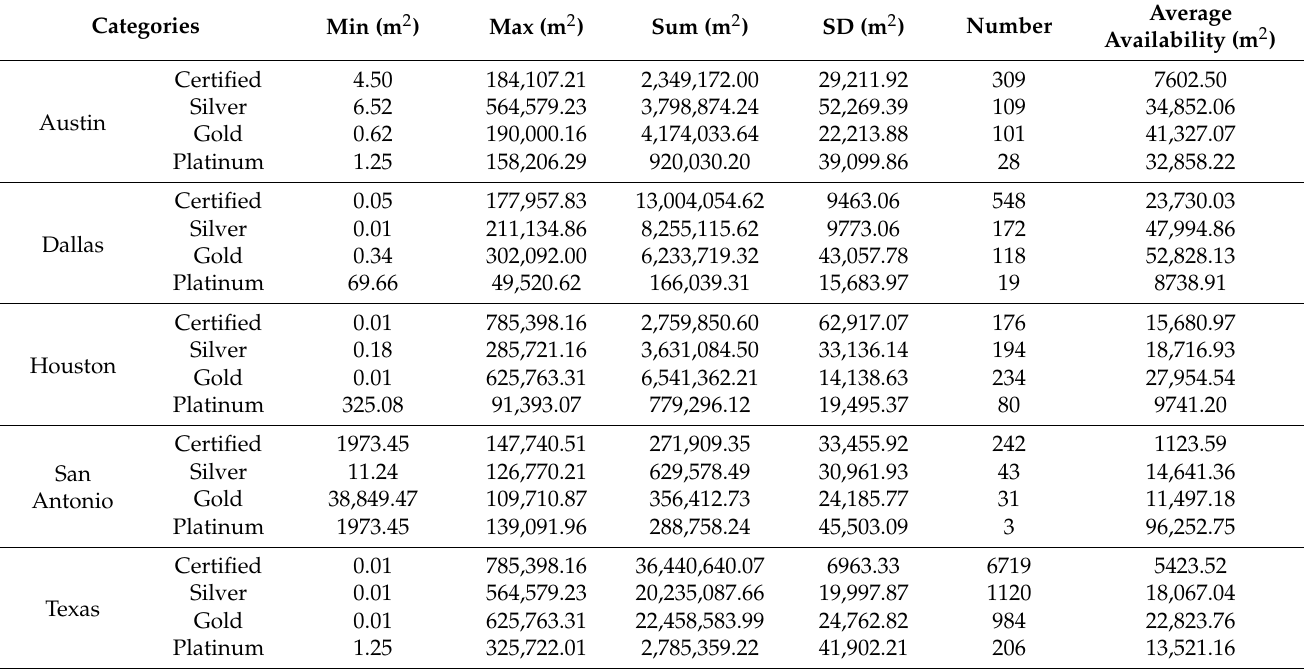
Table 4. Availability of green spaces for different green building certification levels.